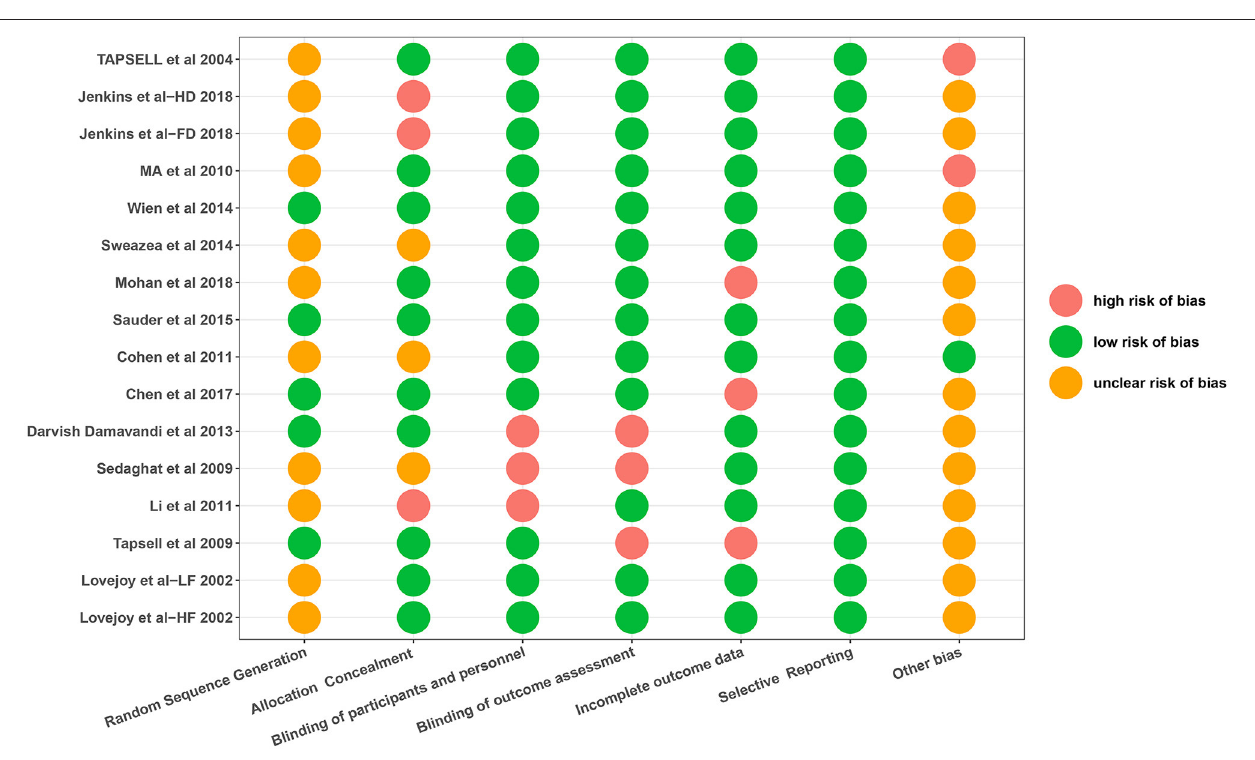
FIGURE 2 | Risk of bias